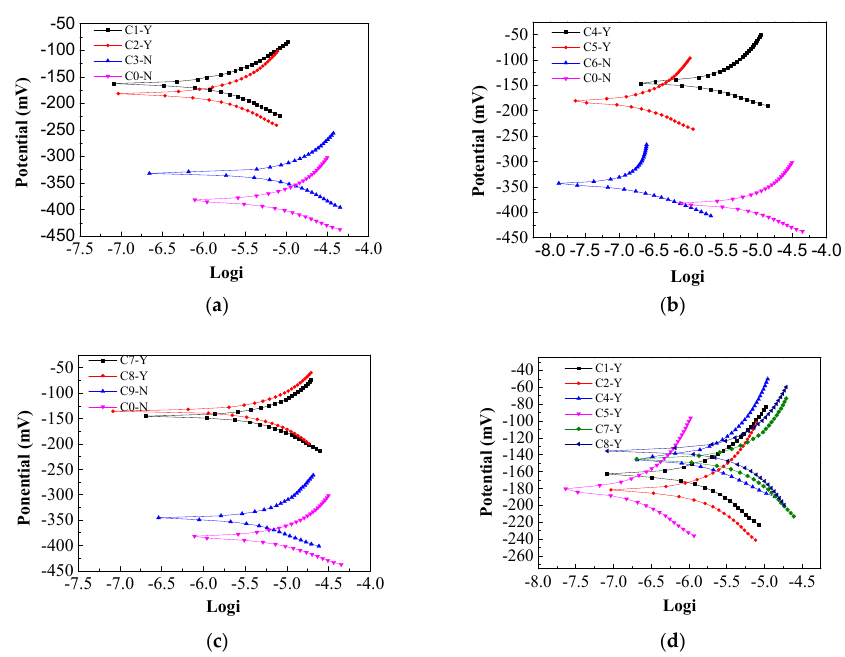
Figure 14. Corrosion potential of reinforcement bar. ( a ) 0.25% imidazoline inhibitor; ( b ) 0.5% imidazoline inhibitor; ( c ) 0.75% imidazoline inhibitor; ( d ) imidazoline